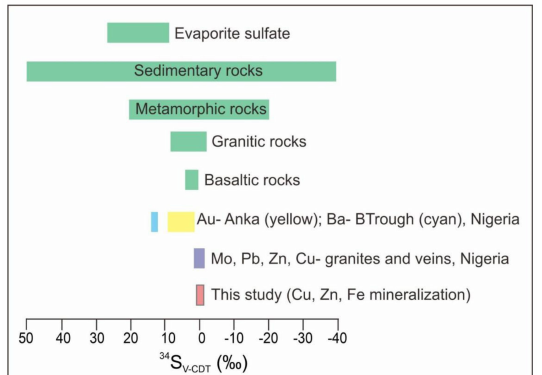
Figure 12. Sulfur isotopic compositions of the sulfides in the Gindi Akwati deposit, compared with some sulfur reservoirs (modified after [50]). The sulfur isotopic data of reservoirs in Nigeria are from previous studies in the text.